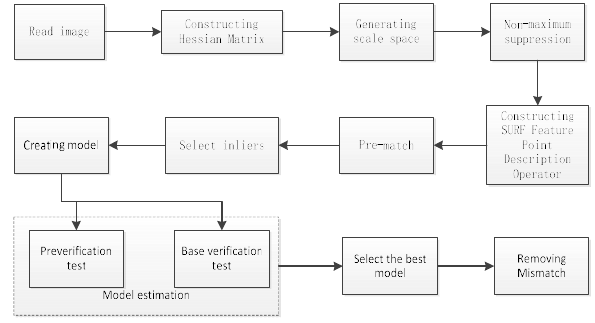
Figure 2. The algorithm flow chart in this paper